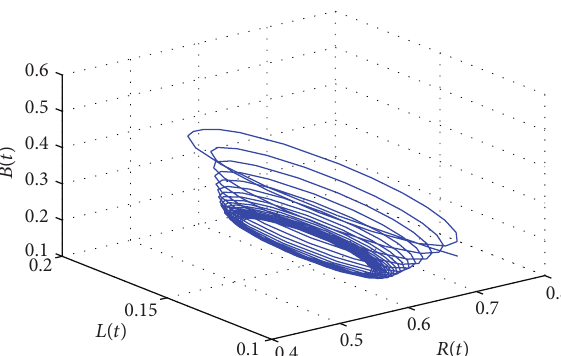
Figure 4: The phase plot of states 𝐿 , 𝐵 , and 𝑅 for 𝜏 = 60.5386 > 𝜏 0 = 58.5472